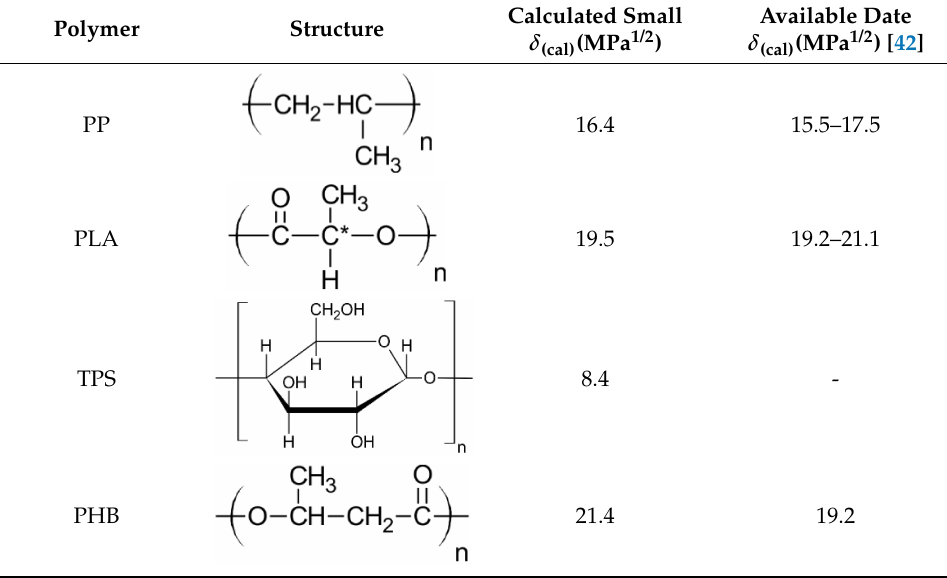
Table 2. Values of the solubility parameters calculated from the present constants.